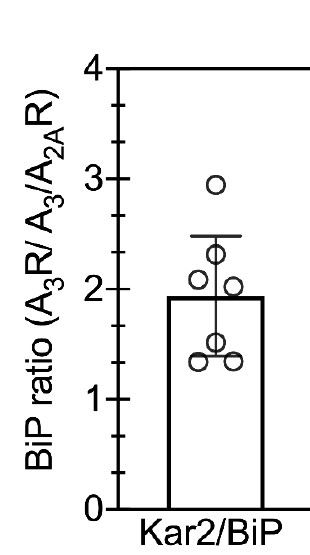
Figure 3. BiP / Kar2 expression was reduced in cells expressing the chimeric A 3 / A 2A R as compared with wild-type A 3 R. ( A ) Representative Western blot of BiP / Kar2 expression levels in recombinant yeast cells. One prominent band (arrow) is observed at the expected MW for BiP / Kar2 of approximately 78 kDa. One OD 600 equivalent of whole cell lysates were loaded per well. Precision Plus Protein WesternC Standard (BioRad) was used to enable molecular weight estimation. ( B ) Quantification of the average integrated band intensities for BiP / Kar2 levels in A 3 R-expressing cell lines from western blot images, divided by BiP levels on the same western in A 3 / A 2A R-expressing cells to yield the fold change. Note this normalization results in no error bars for A 3 / A 2A R data. Experiments were performed for at least four independent biological replicates; error bars represent the 95% confidence interval.